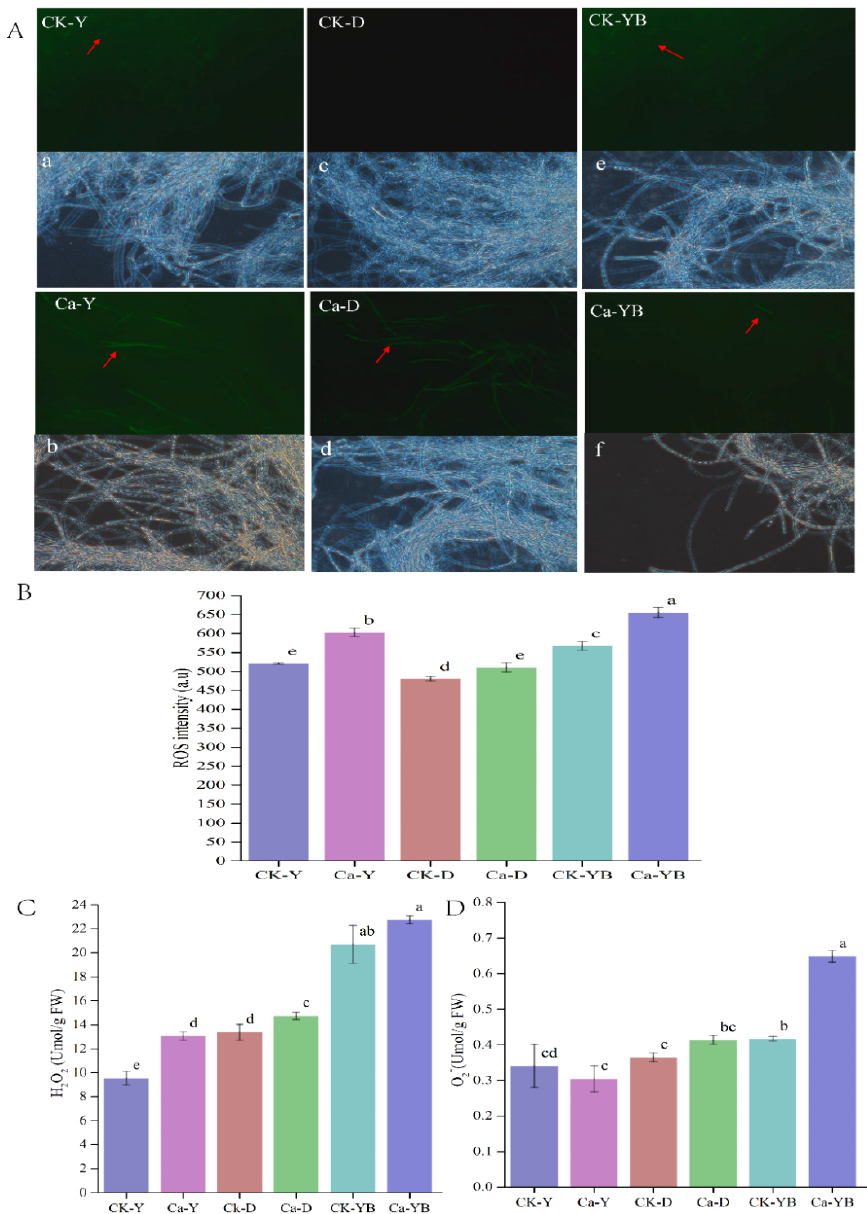
Figure 3. ( A ) ROS, H 2 O 2, and O 2 − contents detection of the mycelia of A. sinodeliciosus var. Chaidam ZJU-TP-08 in yellow–blue LED light shift strategy. Among them ( B , C ), CK-Y, CK-D, and CK-YB represented the no mental ion-treated group with yellow, dark, and yellow–blue shift light, respectively. Ca-Y, Ca-D, and Ca-YB represented the Ca 2+ -treated group with yellow, dark, and yellow–blue shift light, respectively. In ( A ), images a–f represent the bright field figure for the corresponding group (above).